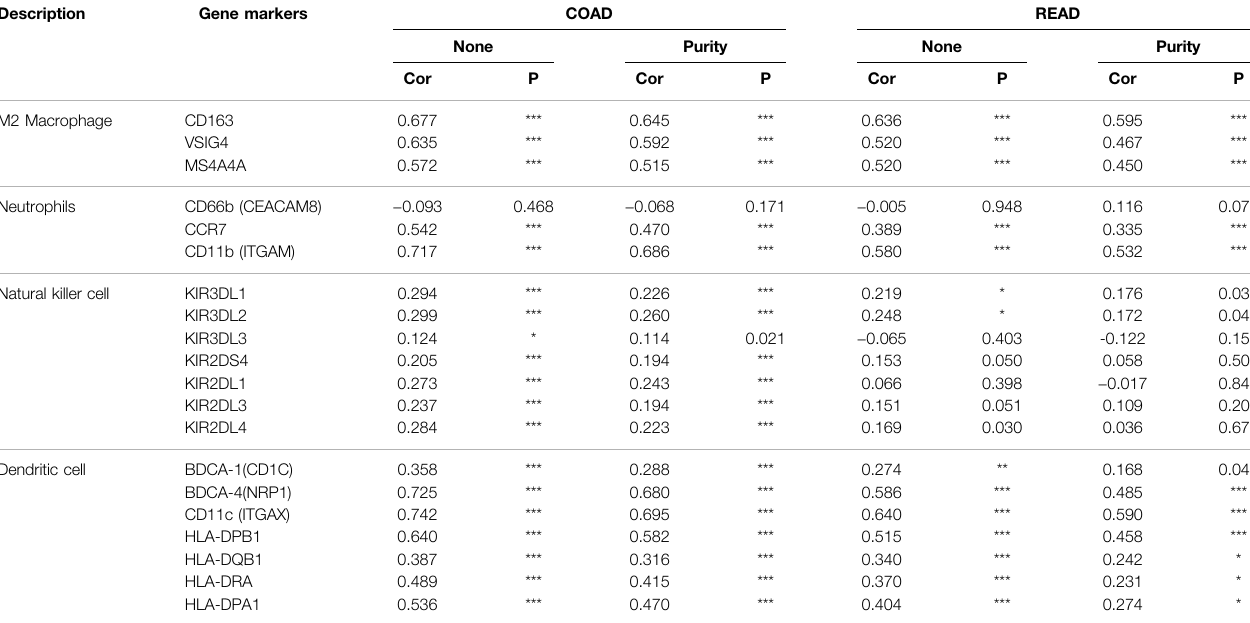
TABLE 1 | ( Continued ) Correlation analysis between SEMA6B and markers of immune cells in